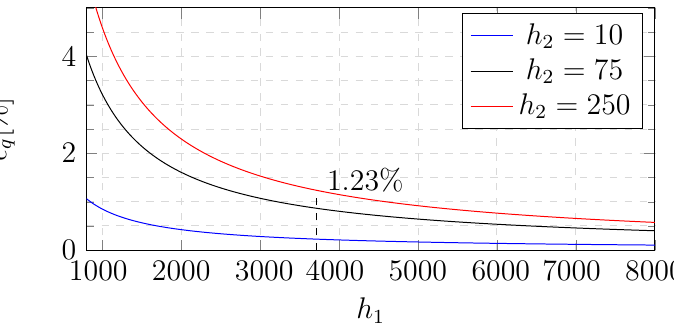
Figure 4. Estimation of bias error (cid:101) h